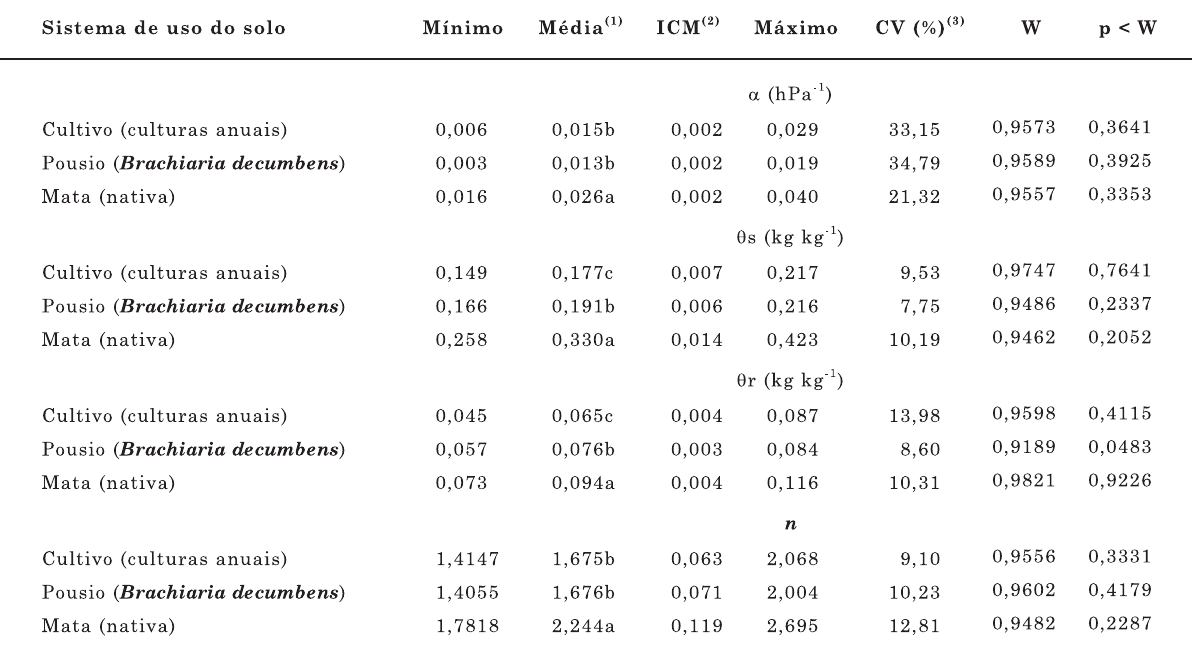
cultivo, pousio e mata (Quadro 3). A correlação positiva dos teores de C orgânico do solo com o θ r no